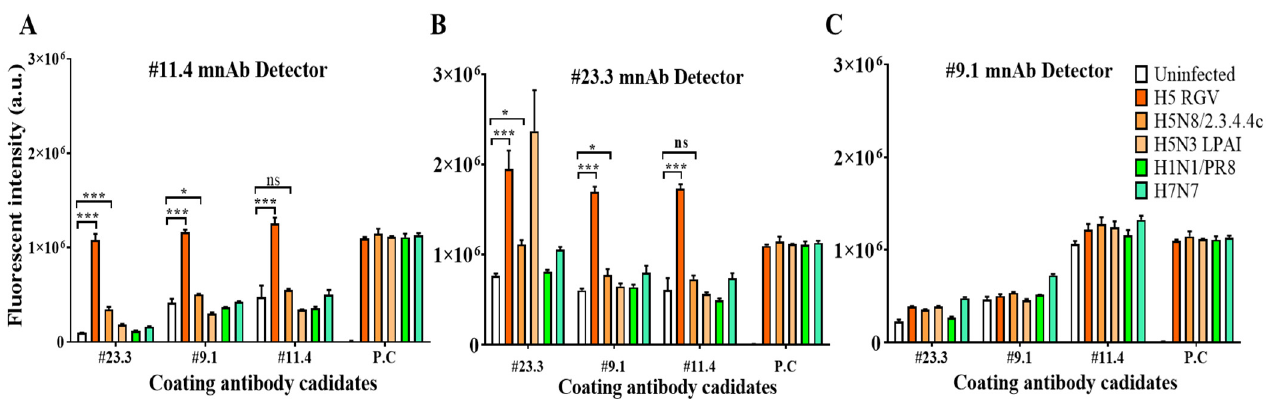
Figure 4. Selection of a specific pair of mAb candidates for H5 HPAIVs detection by sandwich FLISA. The selected mAbs were coated on 96-well plates as capture elements and then detect by Eu NP-conjugated antibodies. ( A ). #11.4 mAb detector, ( B ). #23.3 mAb detector, ( C ). #9.1 mAb detector. The positive control (P.C) is the anti-NP of influenza A virus. One-way ANOVA was used to analyze the data. * p < 0.05; *** p < 0.001; ns, not significant.